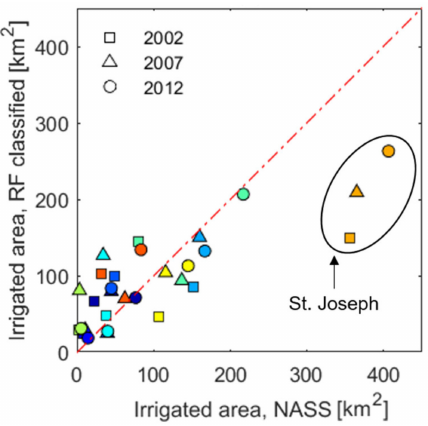
Figure 4. County irrigated area for 2002, 2007, 2012 according to the RF-based irrigation maps. Color encodes different counties. As explained in Section 3.1, RF significantly underestimates irrigated area in St. Joseph county due to widespread seed corn production in that